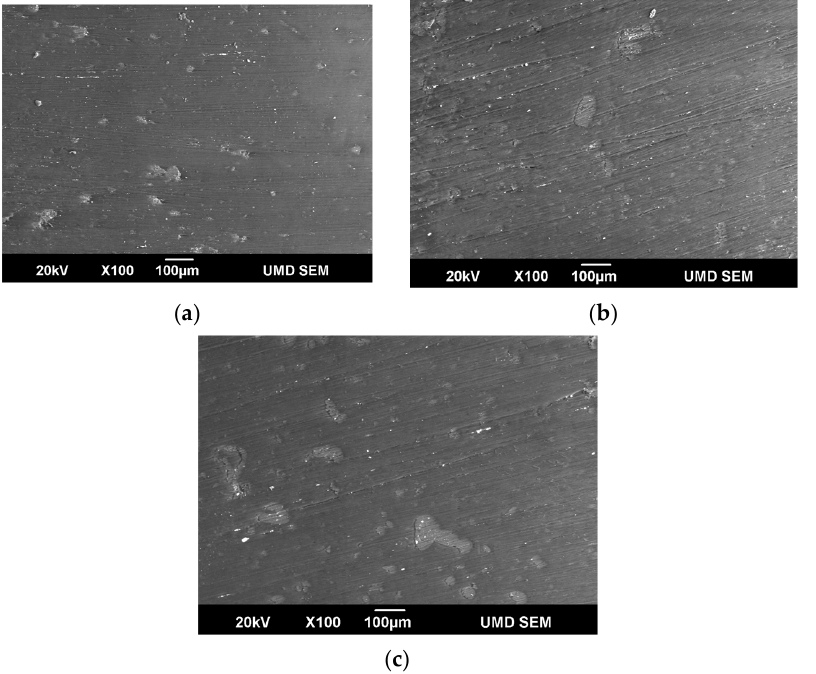
Figure 7. SEM micrograph of ( a ) 10% wt., ( b ) 15% wt., and ( c ) 30% wt. lignin and HDPE blends.